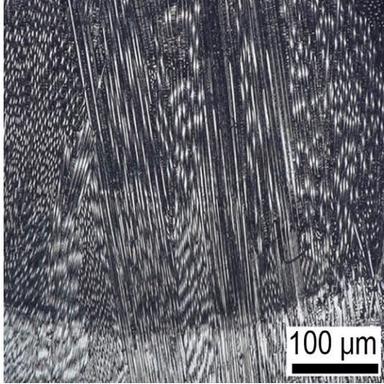
The microstructure in the transient zone.